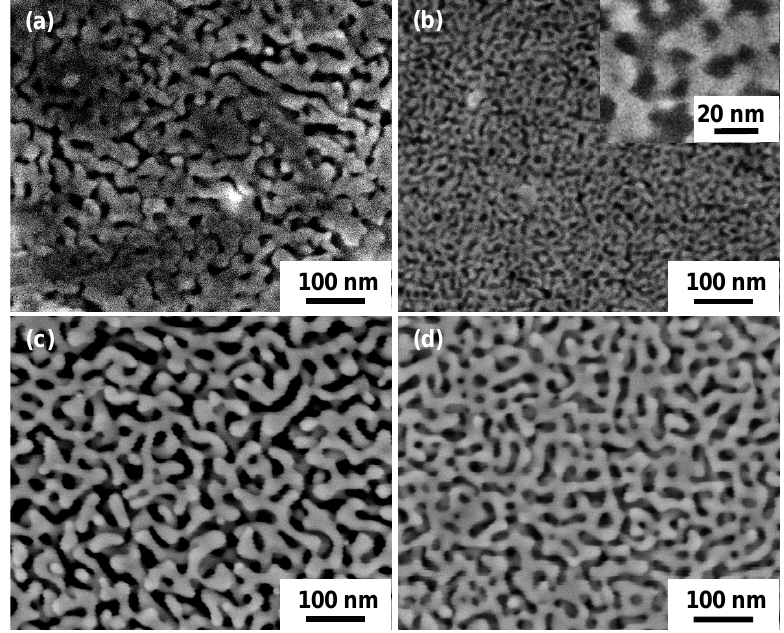
Figure 2. SEM images of NPG produced by dealloying of AN samples with different thickness reductions: ( a ) 0%; ( b ) 60% and ( c ) 90% cold rolled and annealed for a dealloying time of 7 h and ( d ) 98% cold rolled and annealed for a dealloying time of 3 h.